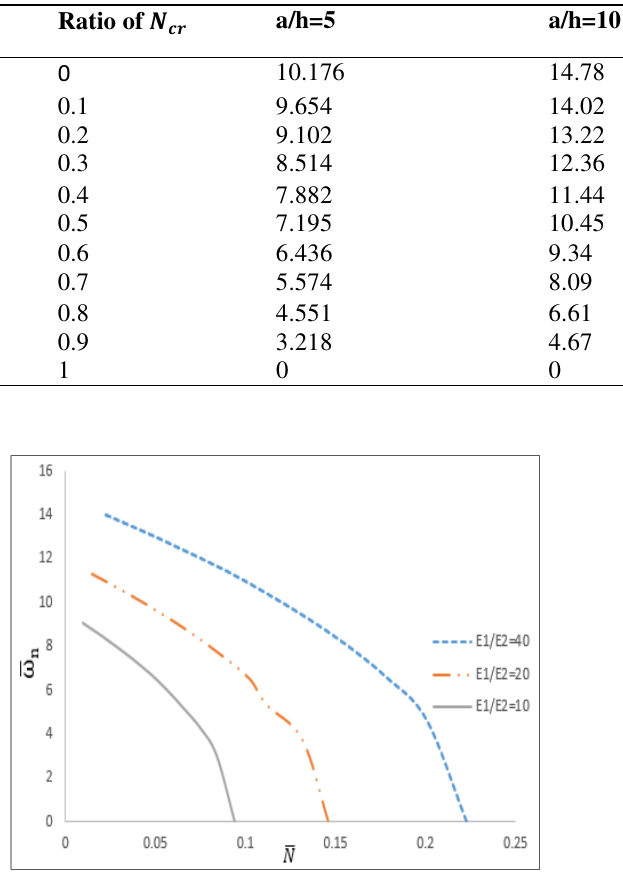
Fig. 3. Natural frequency with ratio of buckling load for [0/90/0] simply supported square plate [a/h=10] for different orthotrpy ratio.